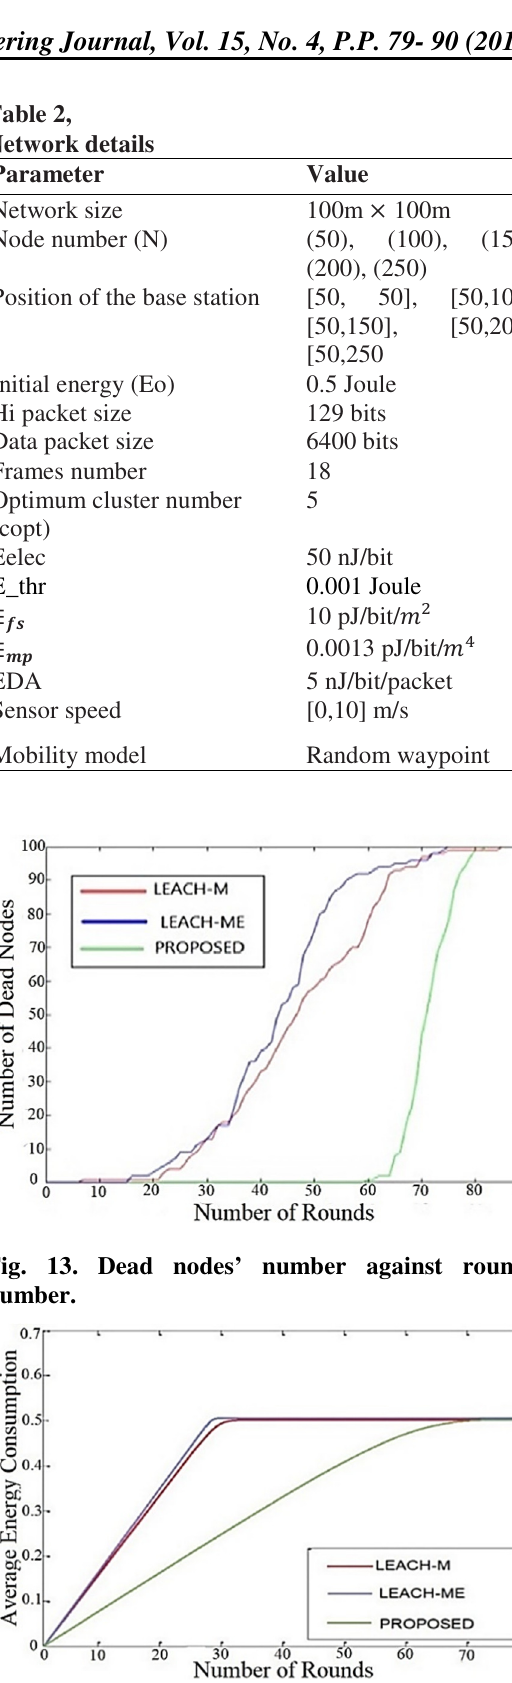
Fig. 14. Mean energy waste in each